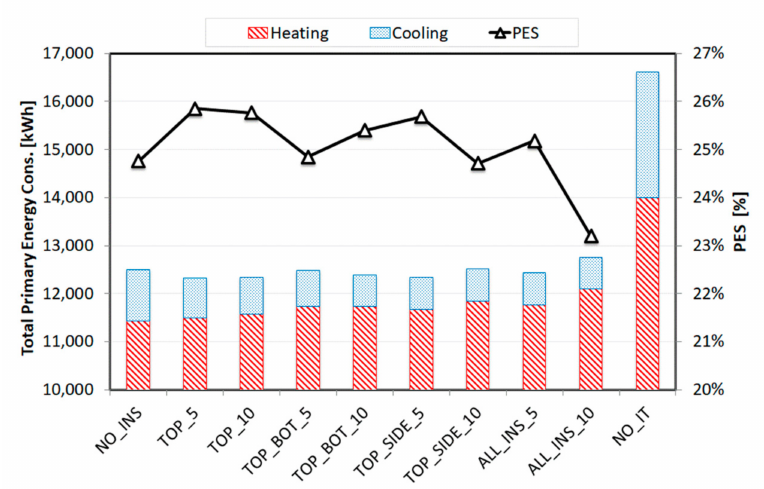
Figure 4. E ff ect of the insulation layout on the annual system performance: non-renewable primary energy consumption (left axis) and primary energy saving (right